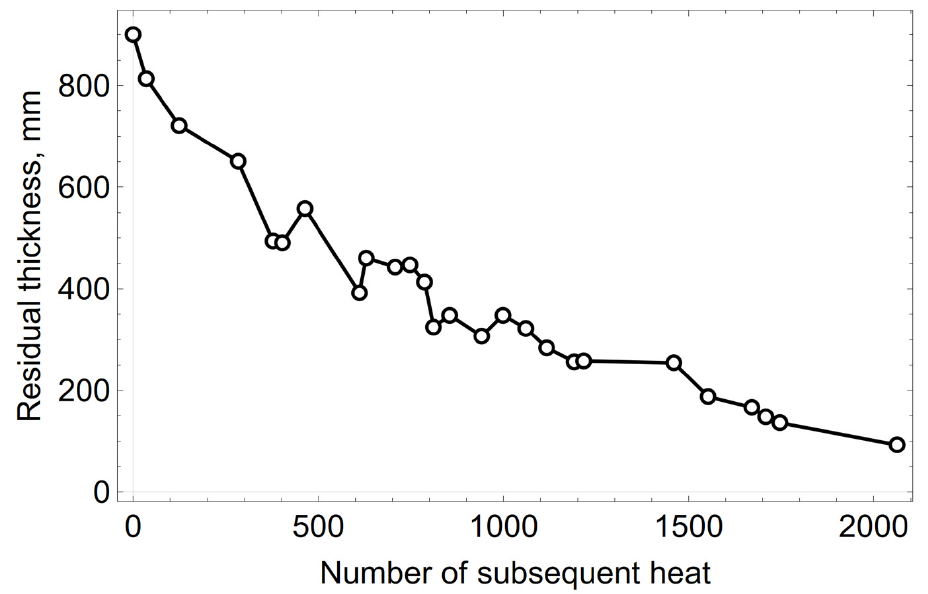
Figure 2. Average residual thickness of the refractory lining of the spout zone.